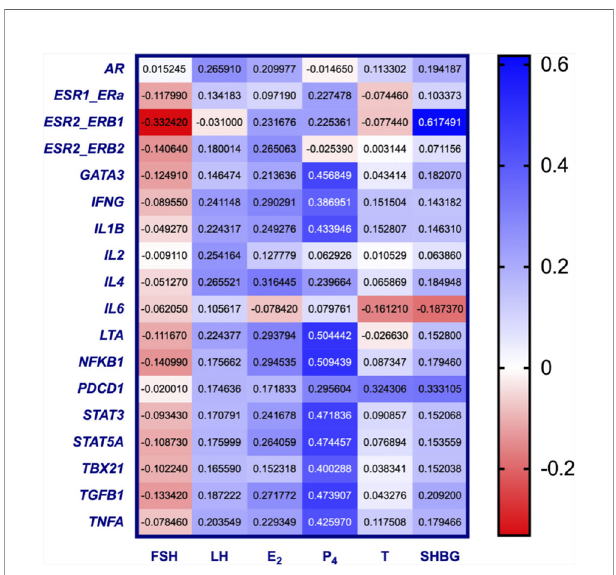
FIGURE 4 | Heat map of repeated measures correlation coef fi cients between serum hormone levels and selected gene expression (- D CT) in PBMCs from pre-MP women. Increased blue color represent increased correlation (r-value ! 1), increased red color represent increased anti-correlation (r-value ! -1), and white represent no correlation (r = 0) ( n = 10, each sampled 4 times). P -values are listed in Supplemental Table 4 ( a =